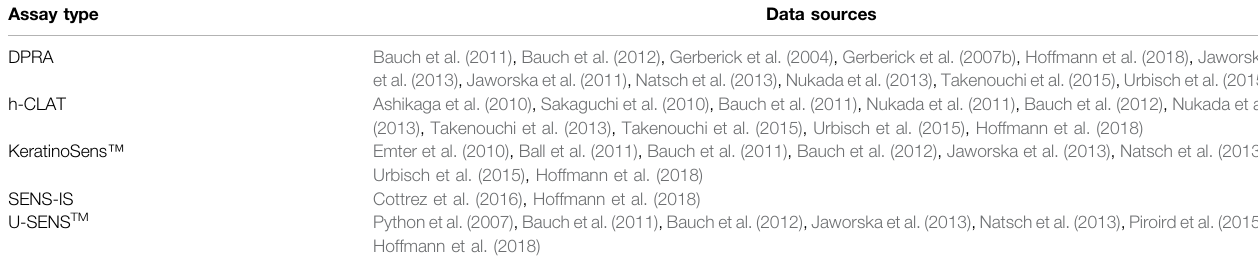
TABLE 5 | Non-animal skin sensitization assay types and data